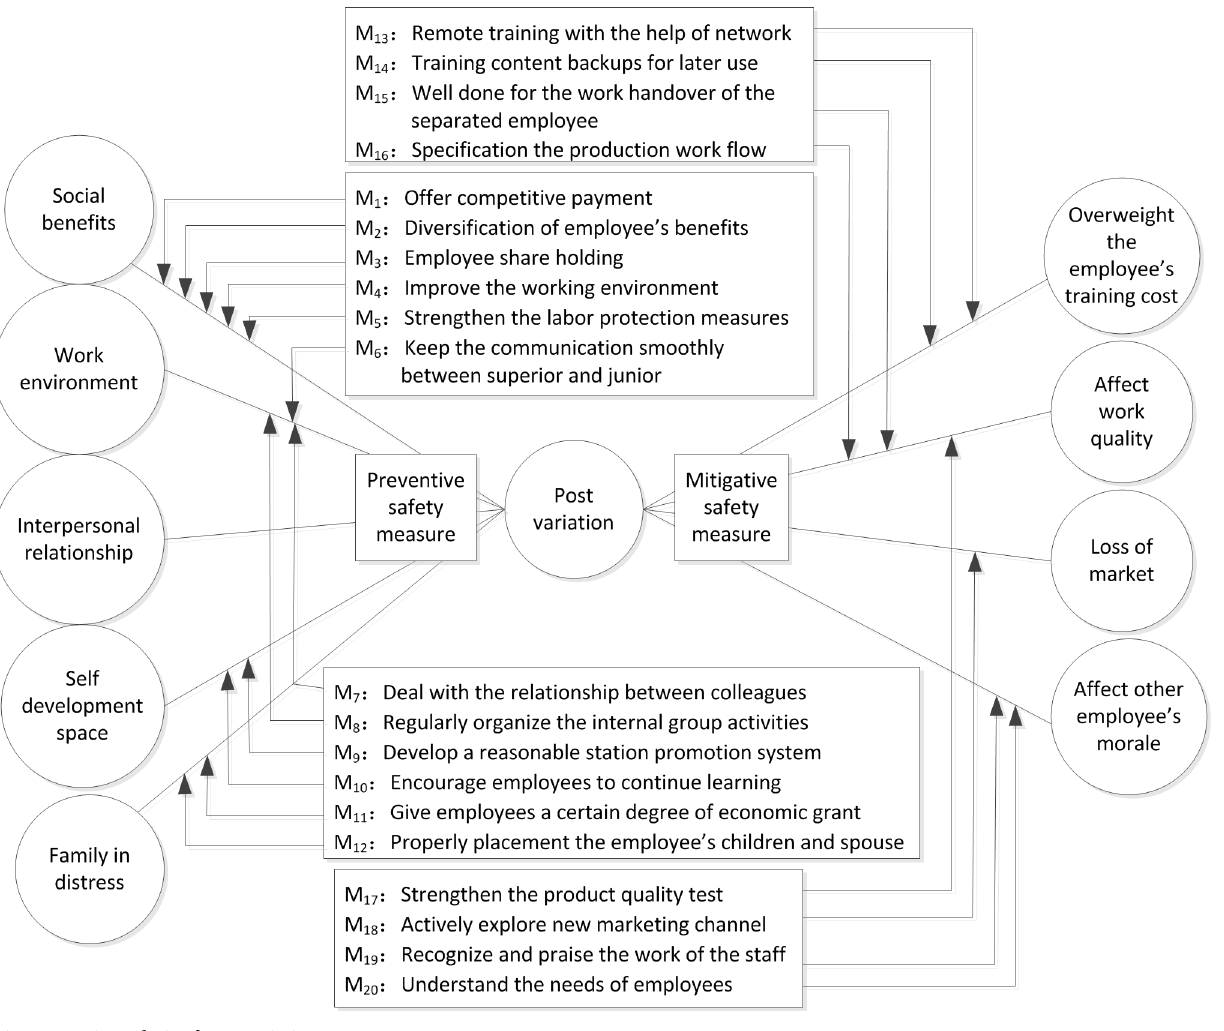
Fig 2. Bow tie analysis of post